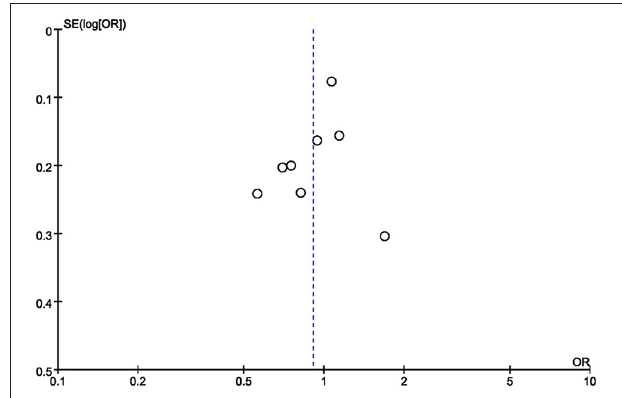
FIGURE 6 | Funnel plot of the association between rs970547 polymorphism in COL12A1 gene and risk of